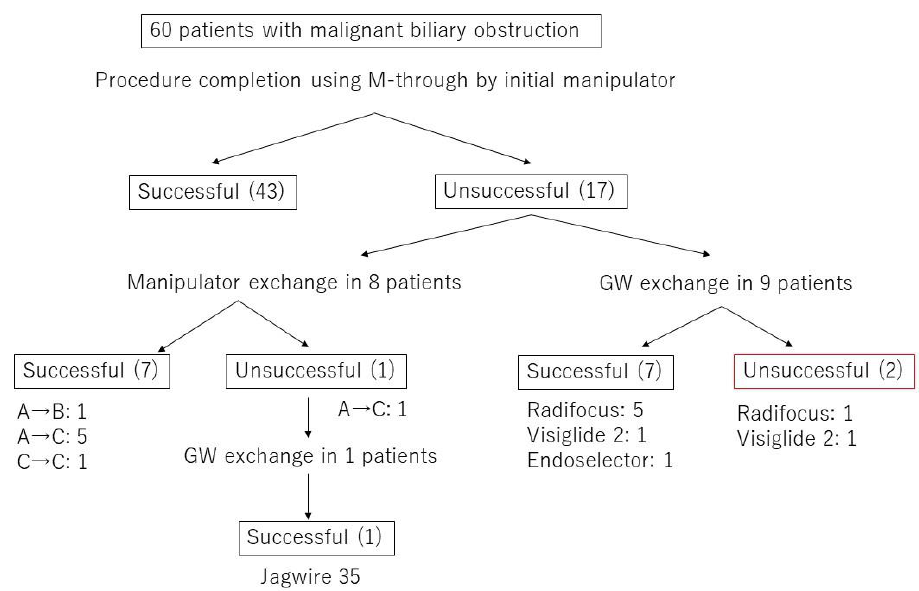
Figure 3. Flowchart of the procedural details including GW and / or manipulator exchange in malignant biliary obstruction (MBO) cases.Experience level of GW manipulator; A was defined as less than five years of experience, B as five years or more but less than 10 years, and C as 10 years or